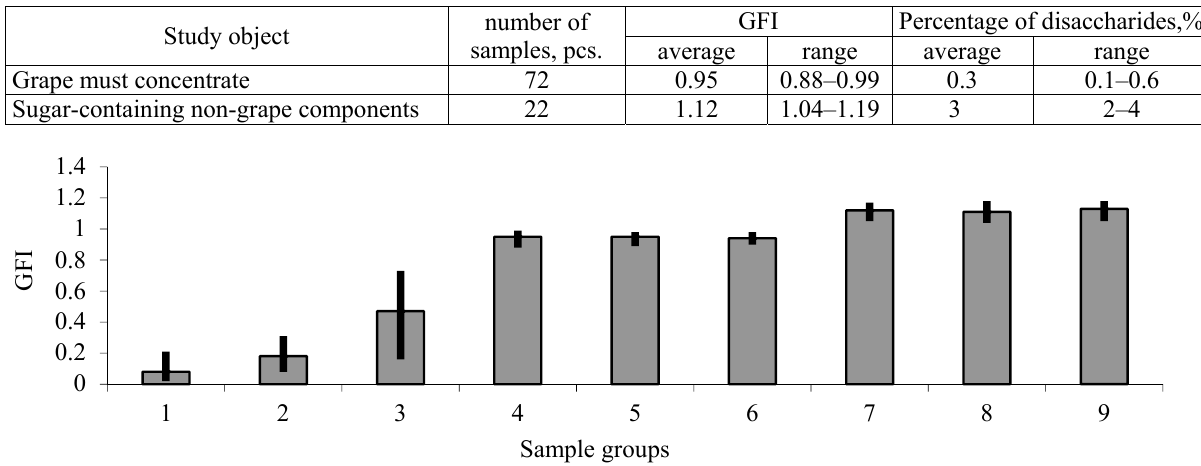
Fig. 3. Glucose-fructose index value in table wines and falsifications (the list of sample groups is provided in the methodological part, Table 1).